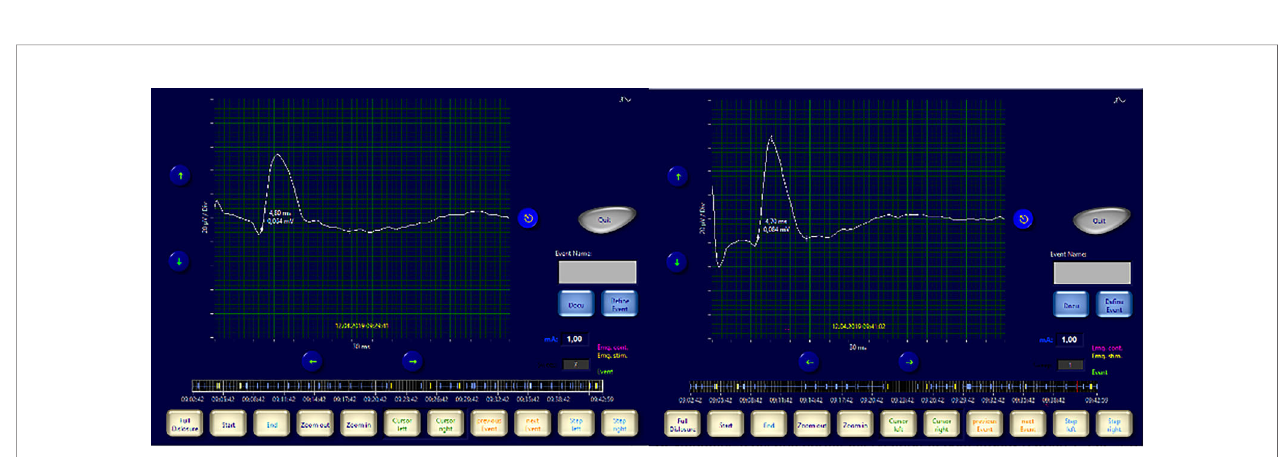
FIGURE 5 | Graphical representation of amplitude and latency values of the responses of the continuous vagal stimulation in a patient with amplitude <100 µV and normal pre- and postoperative vocal cord